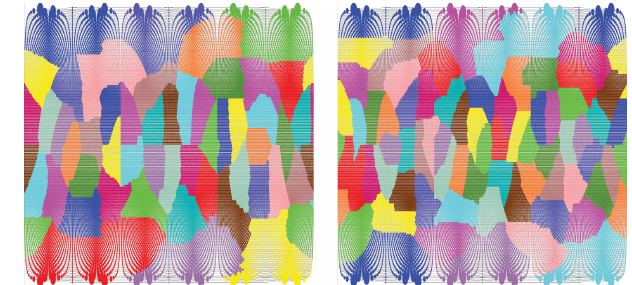
Figure 15. Mesh partitioning computed by the general purpose mesh partitioner Scotch for 54 domains (optimal case for Pangolin, left) and 72 domains (sub-optimal case for Pangolin, right). Each color corresponds to a subdomain (the same color can be used for different partitions). The grid contains 48600 cells and is shown in latitude–longitude